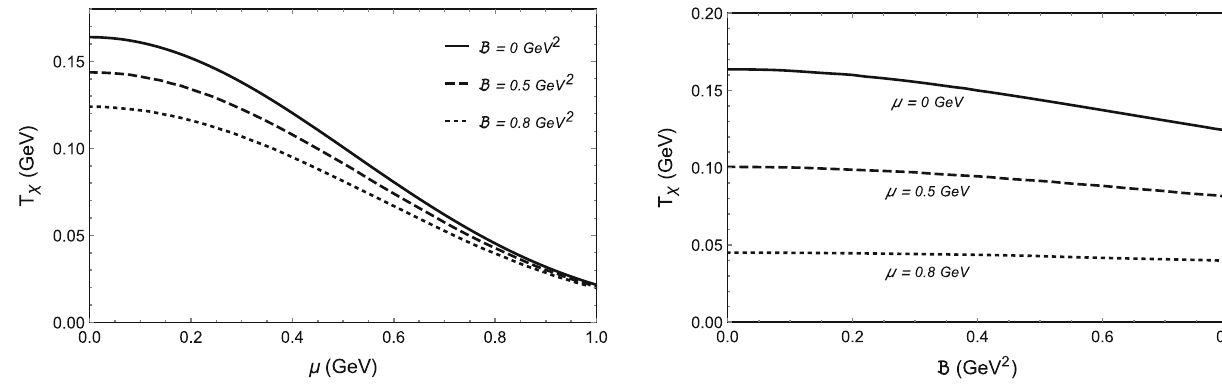
Fig. 1 The chiral transition behaviors (left panel) and the variations of ∂σ/∂ T (right panel) with different μ and B . The solid, dashed and dotted curves denote the cases with B = 0 , 0 . 5 , 0 . 8 GeV 2 respectively, while the blue, green and red colors denote the cases with μ = 0 , 0 . 5 , 0 . 8 GeV respectively